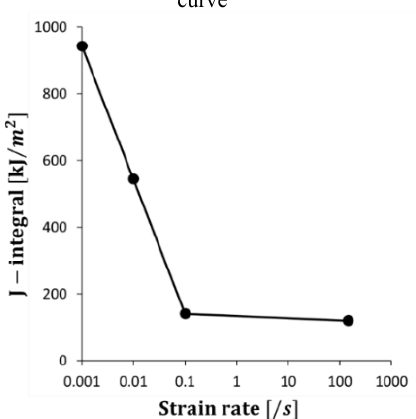
Fig. 5 Relationship between J-integral and strain rate